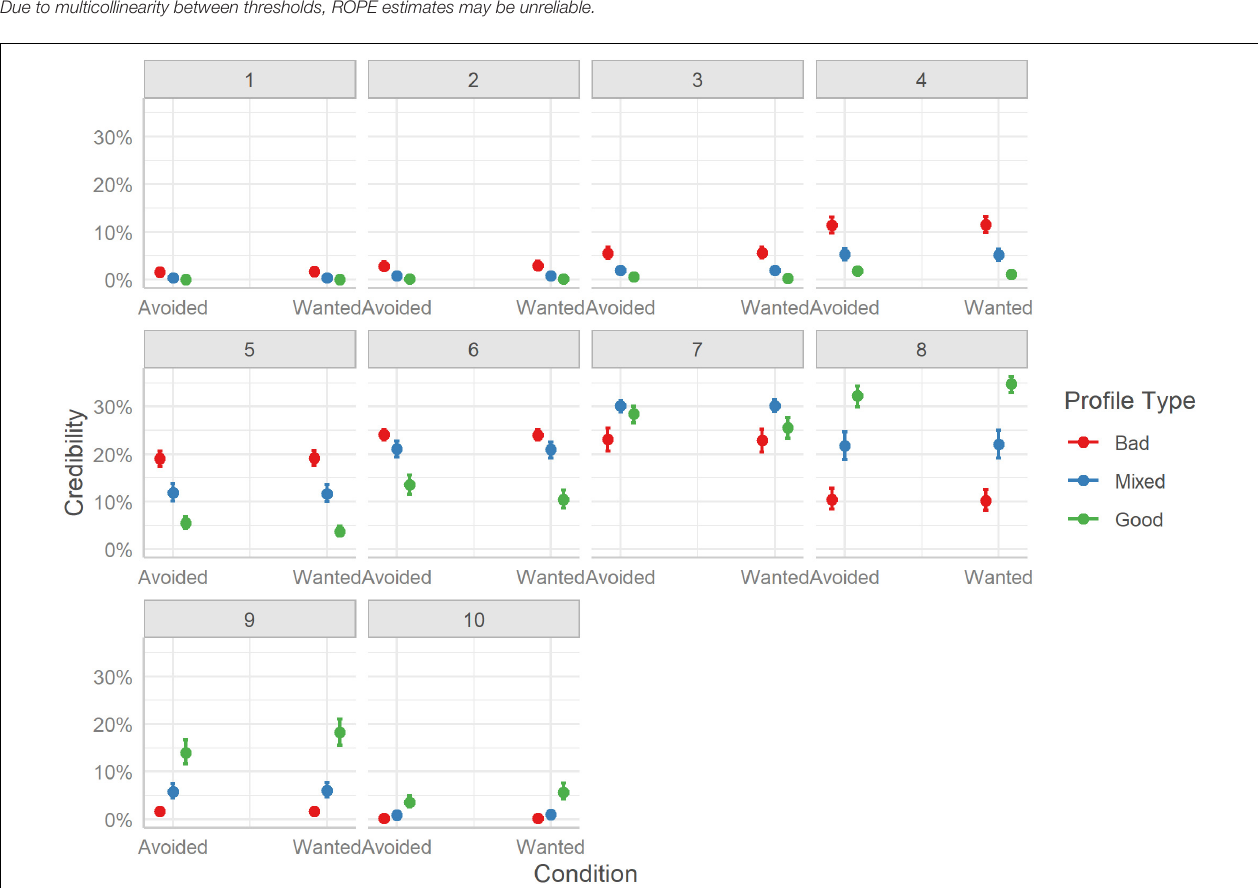
FIGURE 15 | Marginal effects of trustworthiness. The posterior mean estimates of the probability of responses in each of the three Profiles (Bad, Good, Mixed) by the two experimental Conditions (Avoided or Wanted). Error bars indicate 95% credible